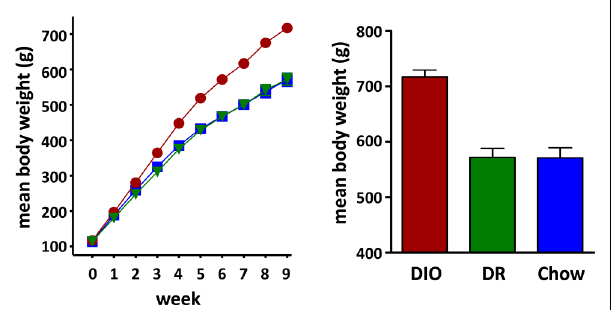
FIGURE 1 | Diet Induced Obesity (DIO) Phenotype: mean weekly body weight of rats classified as DIO (red circle) or diet resistant (DR, green triangle) after 8 weeks of ad libitum feeding on a HFD and age- matched chow fed controls (Chow, blue square) Bar graph on the right shows the mean body weights of rats considered DIO or DR based on those who gained the greatest and least weight, respectively, and age-matched chow fed control animals at time of group